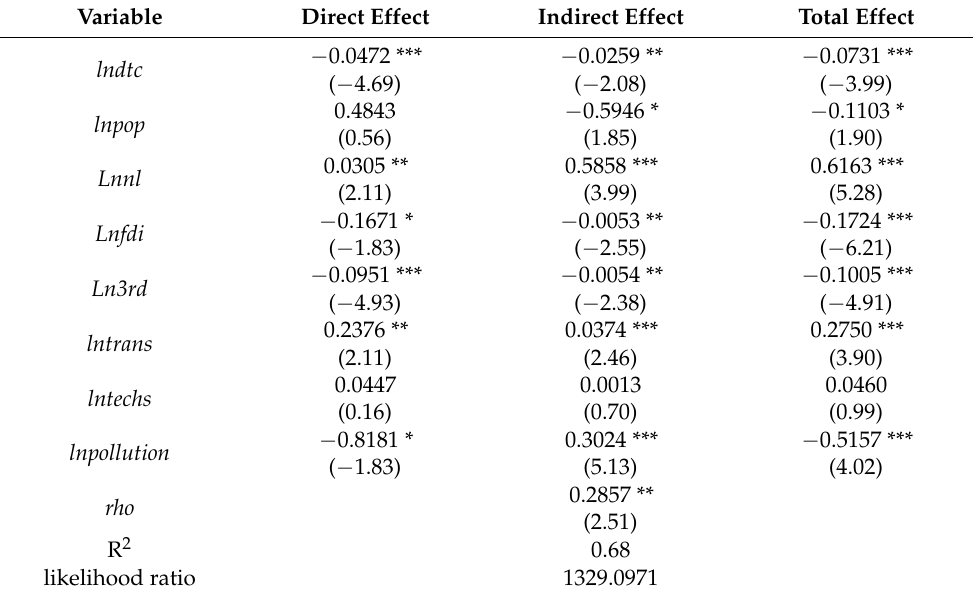
Table 6. Direct and indirect effects of the